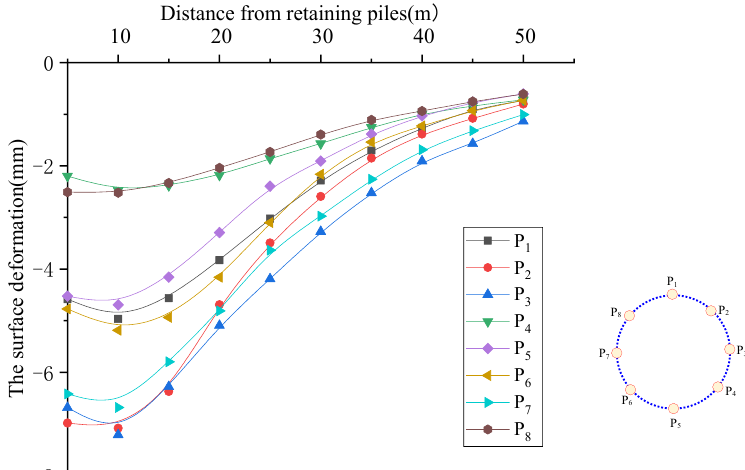
Figure 9. The surface deformation of the ground surface around the foundation pit.